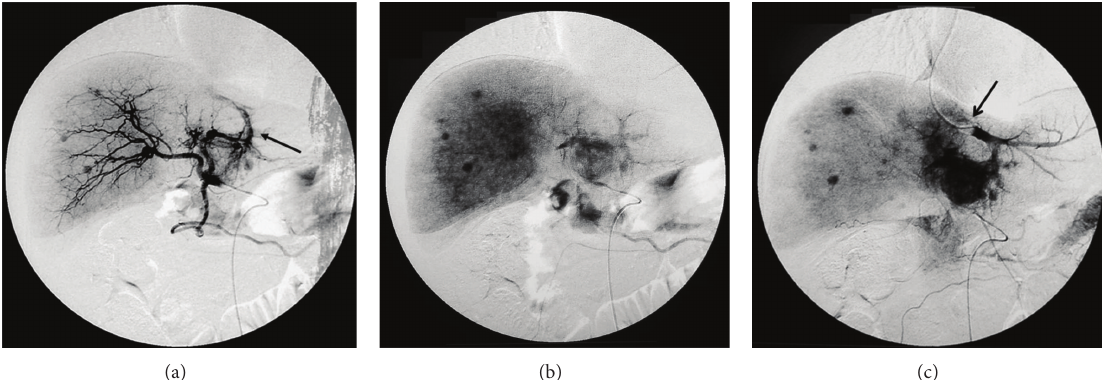
Figure 2: Multiple HCCs with significant arterio-left hepatic vein shunt in a 71-year-old man. Common hepatic arteriography ((a): arterial phase, (b): venous phase) reveals multiple HCCs with significant arterio-left hepatic vein shunts ((a), arrow). Common hepatic arteriography under balloon occlusion of the left hepatic vein demonstrates a dense opacified tumor (c). Arrow of (c) indicates the balloon in the left hepatic vein.